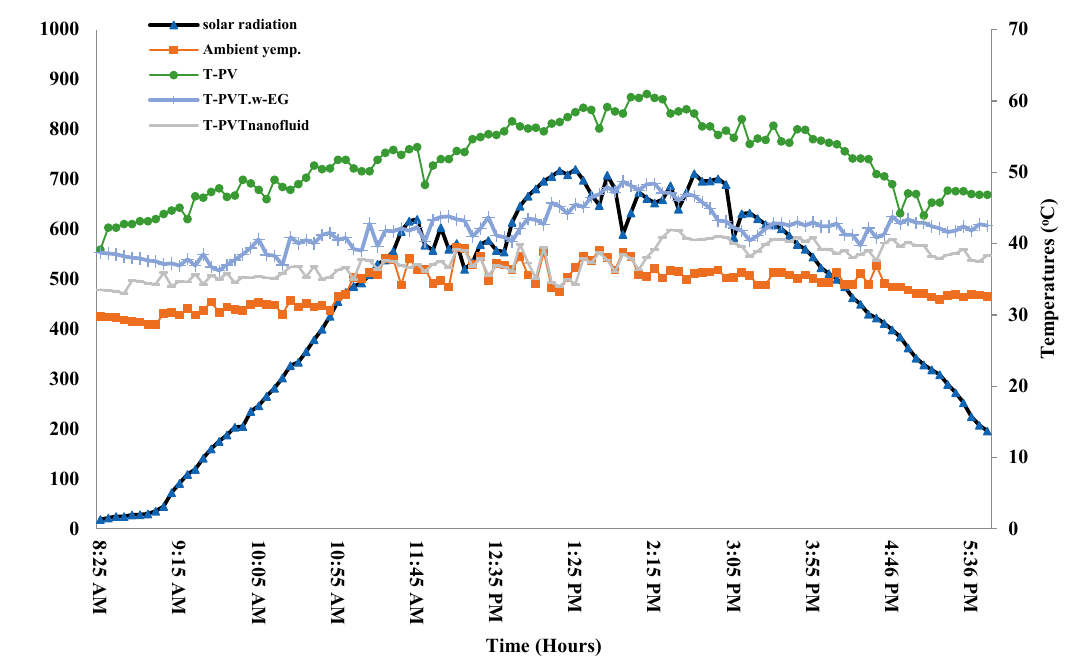
Figure 2. The solar radiation and various temperatures measured during the test days.